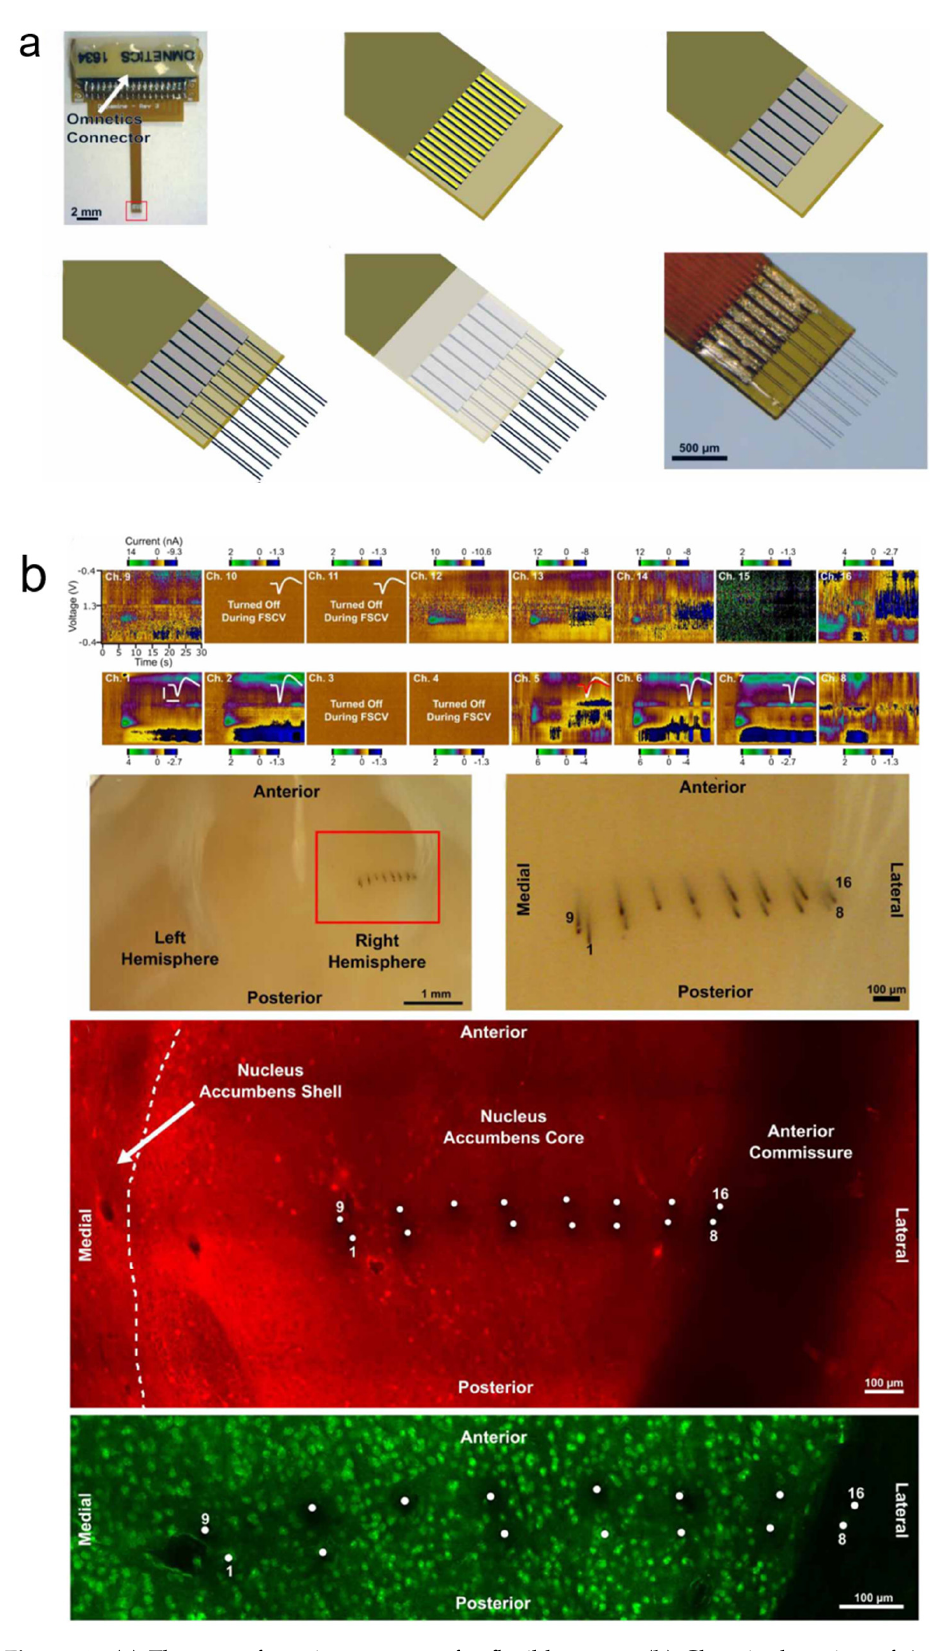
Figure 4. ( a ) The manufacturing process of a flexible array. ( b ) Chronic detection of AA and electro- physiology signals, carbon fiber anatomical localization, and immunohistological